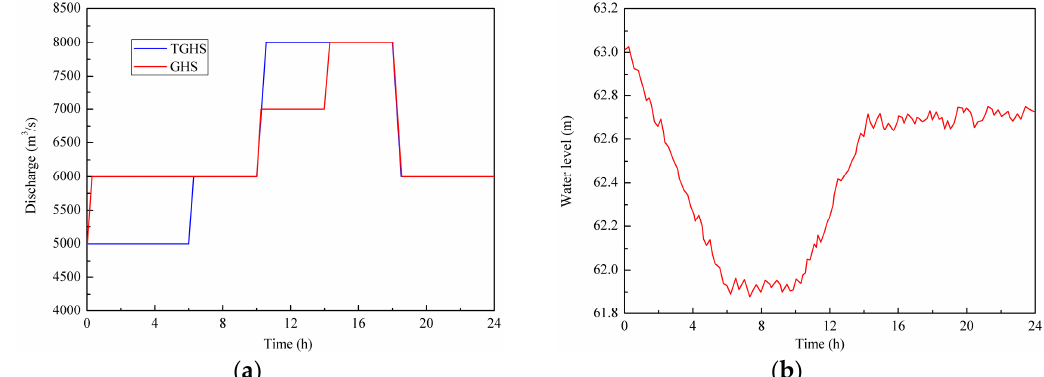
Figure 13. Computation boundary. ( a ) Flow process of the Three Gorges Hydropower Station (TGHS) and the Gezhouba Hydropower Station (GHS); ( b ) Water level at the Xitan Station. Quantitative